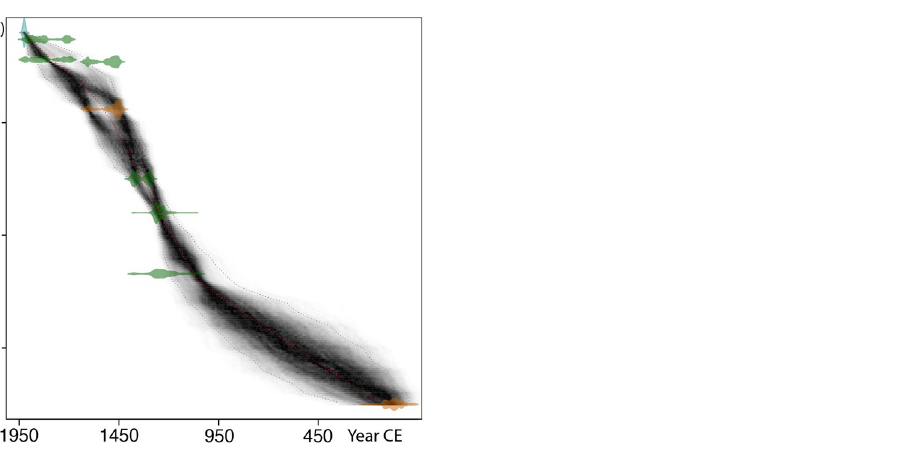
Figure 6. The Mulyoungari sediment core age depth profile. The previously reported radiocarbon dates were used for the age depth model 30 . Age probability distributions are plotted in light brown for bulk sediment samples and in green for plant samples. The best age depth model (red dot line) with a 95% confidence interval (gray dot line) was established based on Bayesian principles using Bacon 2.2 74